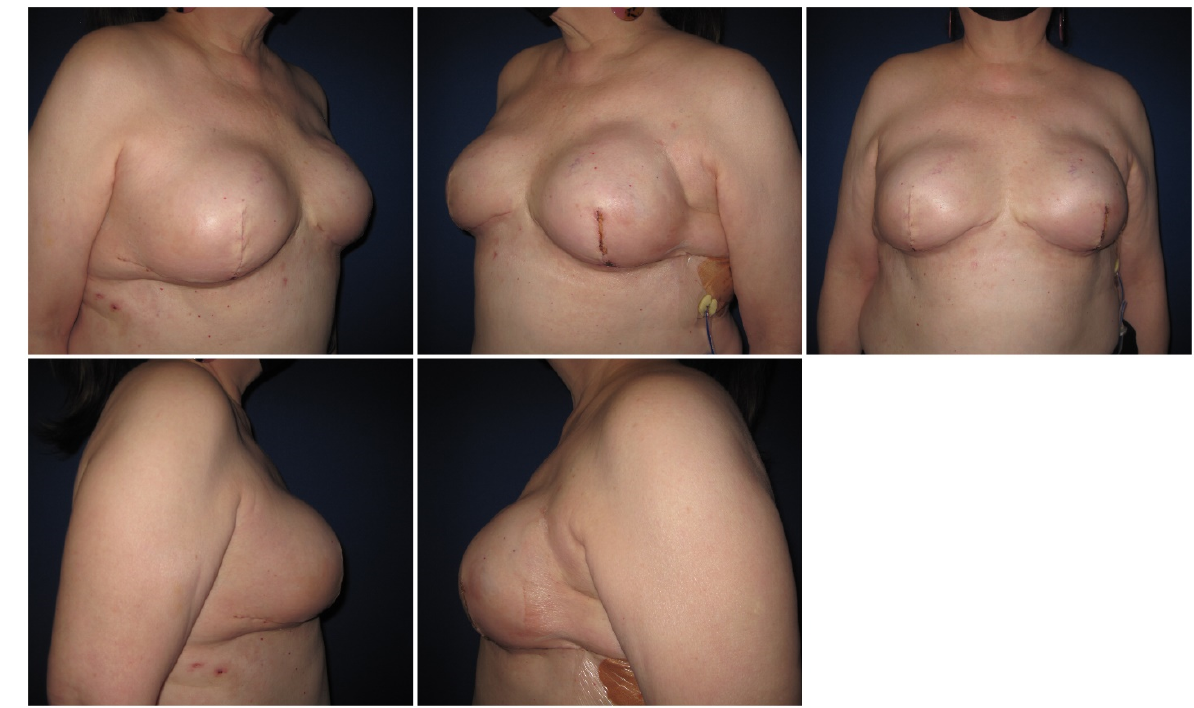
Figure 3. Immediate post-operative pictures.